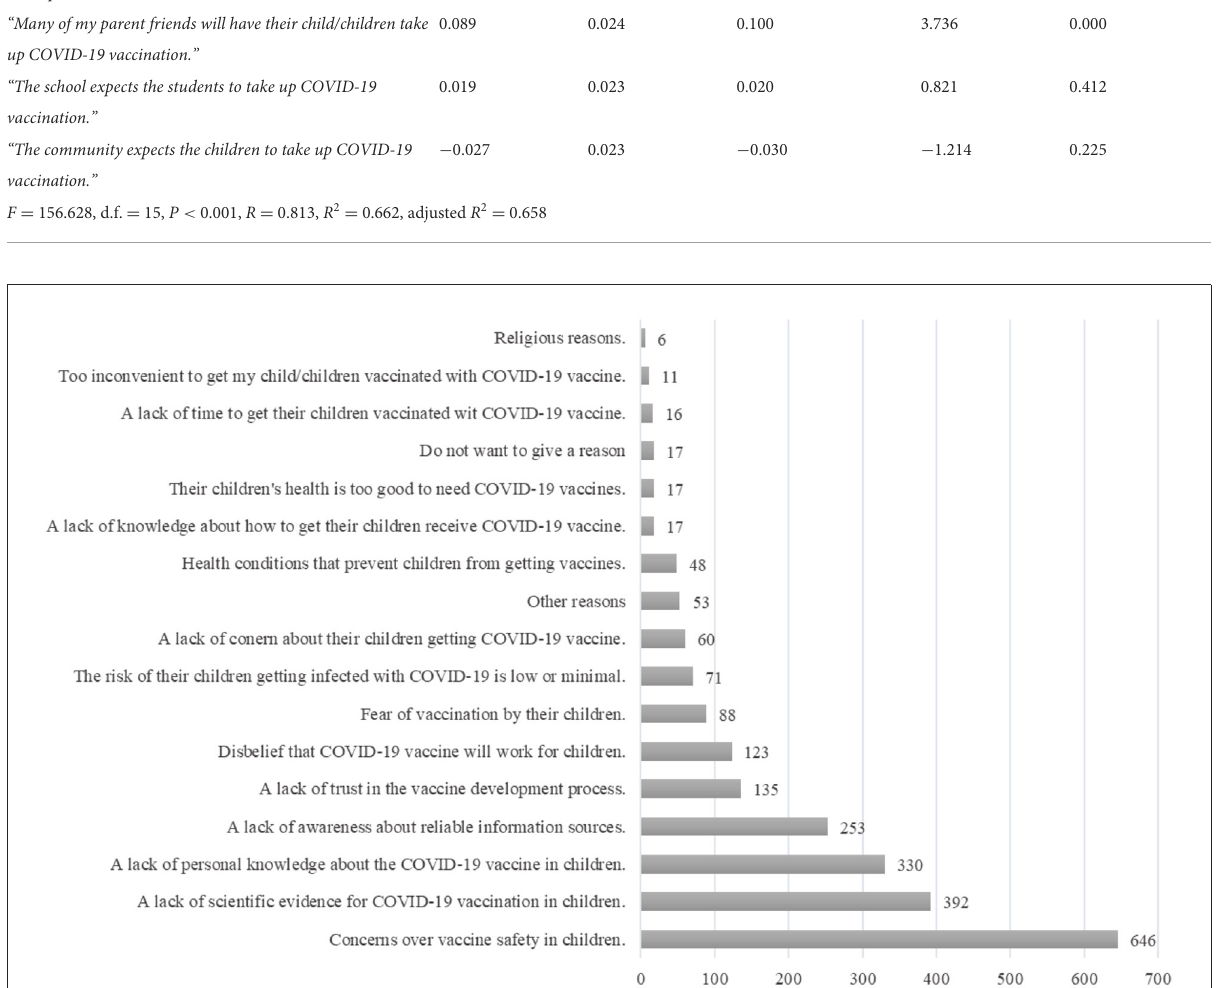
disbelief that COVID-19 vaccine would work for children ( n = 123/699,